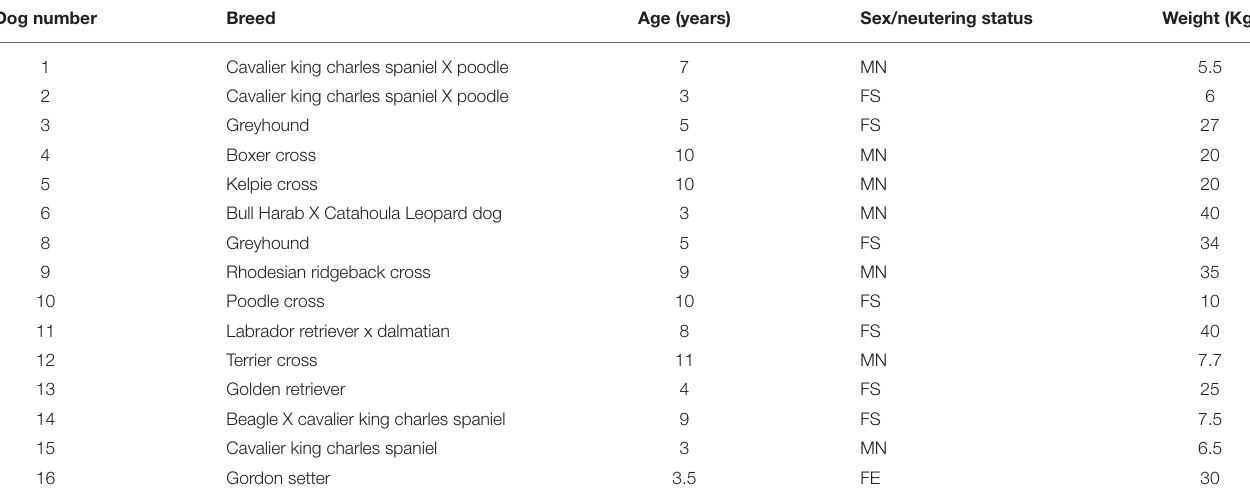
TABLE 1 | Signalment information of study population. Dog number